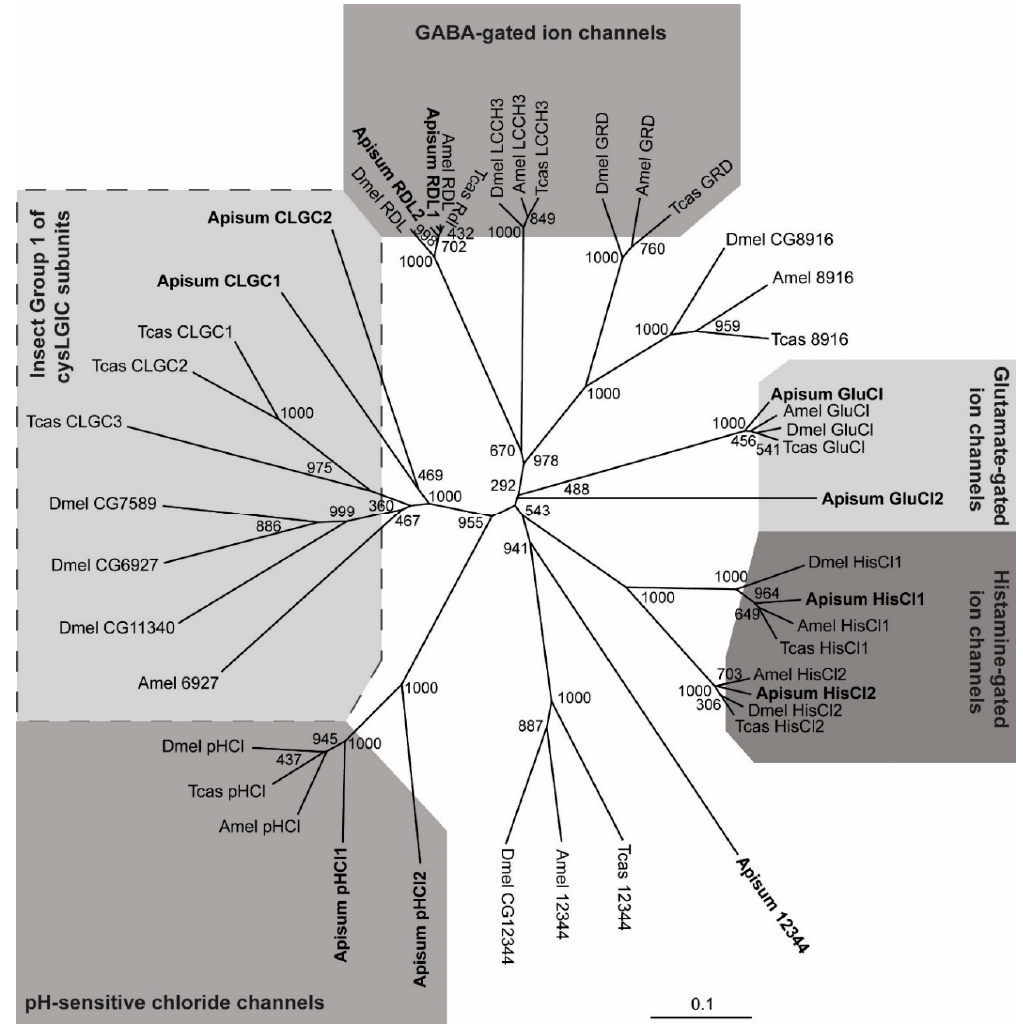
Figure 2. Tree showing relationships of A. pisum , A. mellifera , D. melanogaster and T. castaneum cysLGIC subunits. Numbers at each branch signify bootstrap values with 1000 replicates, and the scale bar represents substitutions per site. A. pisum cysLGICs are shown in boldface type.